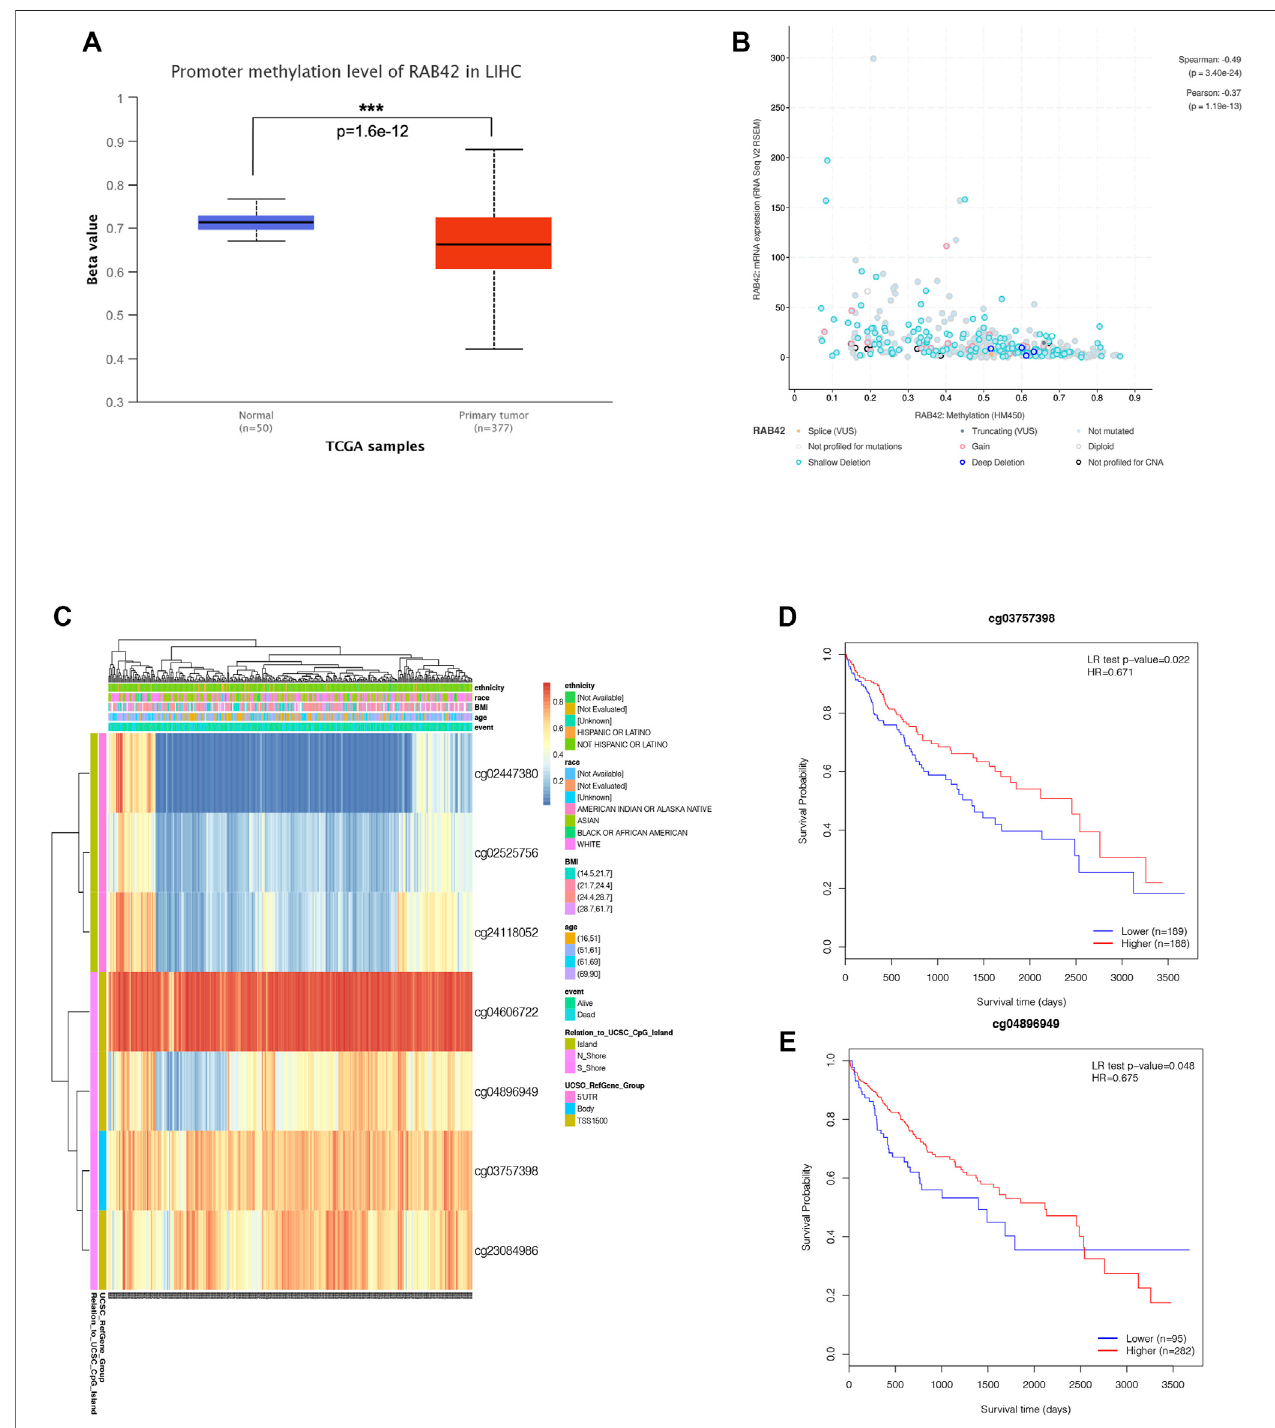
FIGURE 5 | DNA methylation expression level of RAB42 in HCC. (A) Promoter methylation level of RAB42 in HCC and normal tissues were analyzed with TCGA data by using UALCAN database. (B) Correlation between RAB42 mRNA expression and DNA methylation level was analyzed with TCGA data by the cBioPortal database(Spearman ’ scorrelationr= − 0.49, p -value=3.40E − 24). (C) TheheatmapshowedtheRAB42DNAmethylationatCpGsitesbyusingtheMethSurvdatabase. (D) HCCpatientswithlowerRAB42methylationofcg03757398CpGsiteshadaworseoverallsurvivalthanthosewithhigherRAB42methylation(HR=0.671, p = 0.022). (E) HCC patients with lower RAB42 methylation of cg04896949 CpG sites had a worse overall survival than those with higher RAB42 methylation (HR = 0.675, p = 0.048).